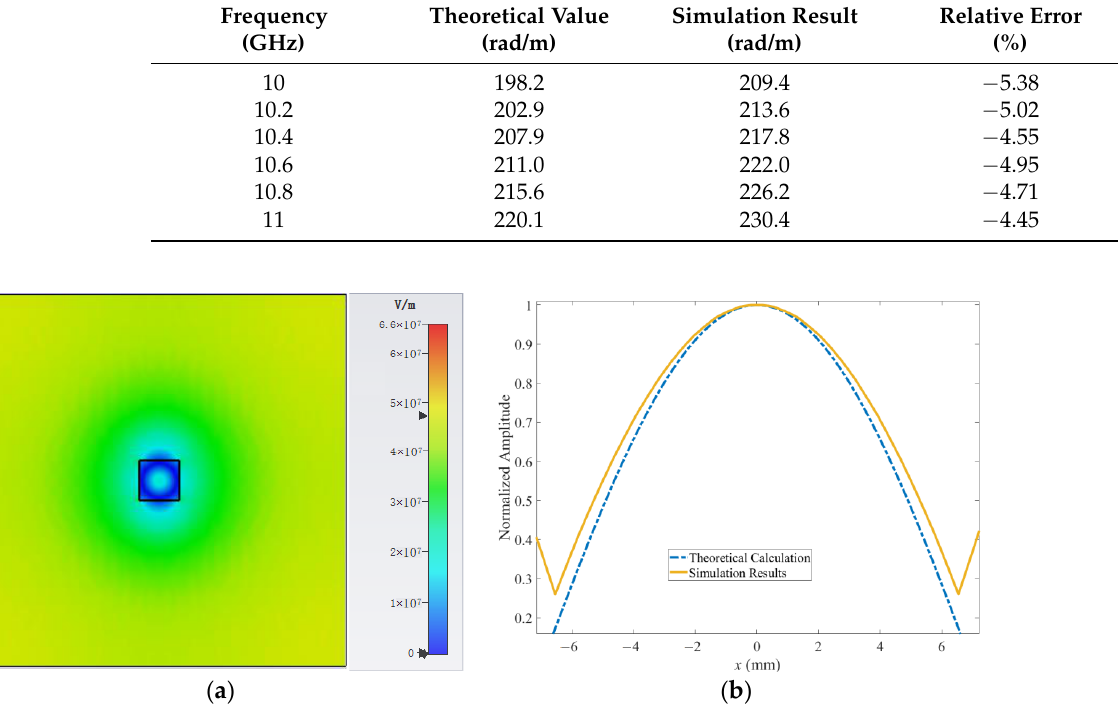
Figure 8. Field distribution of leaky mode in cross-plane: ( a ) cross-plane field distribution of leaky mode simulated by Eigenmode Solver, ( b ) simulated and calculated field strengths along x axis. Table 2. Theoretical and simulated real parts of longitudinal phase constants for leaky mode.